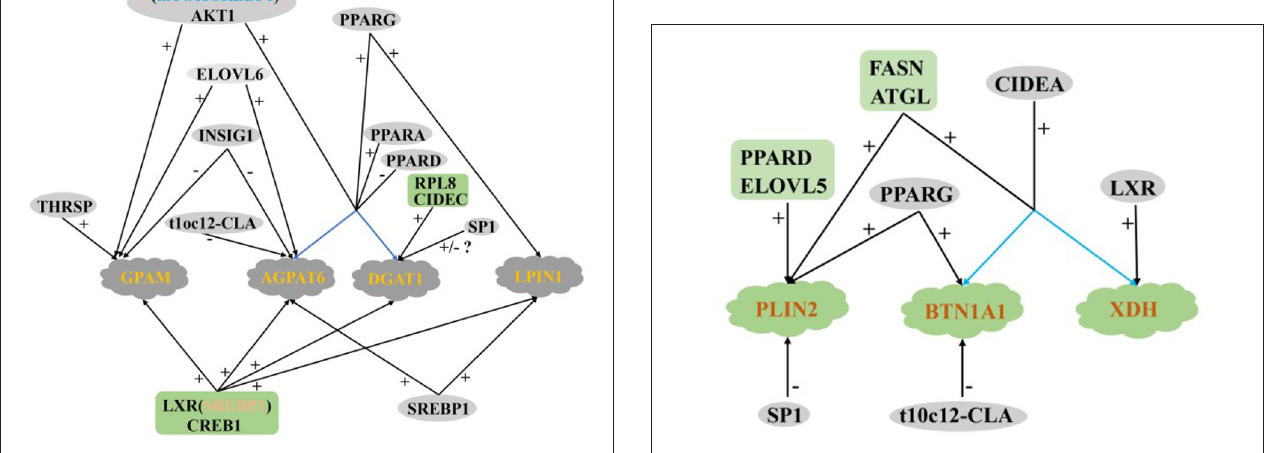
FIGURE 5 | Regulatory network of key genes in ruminant MECs TAG synthesis. + : Positive regulation; –: Negative regulation.